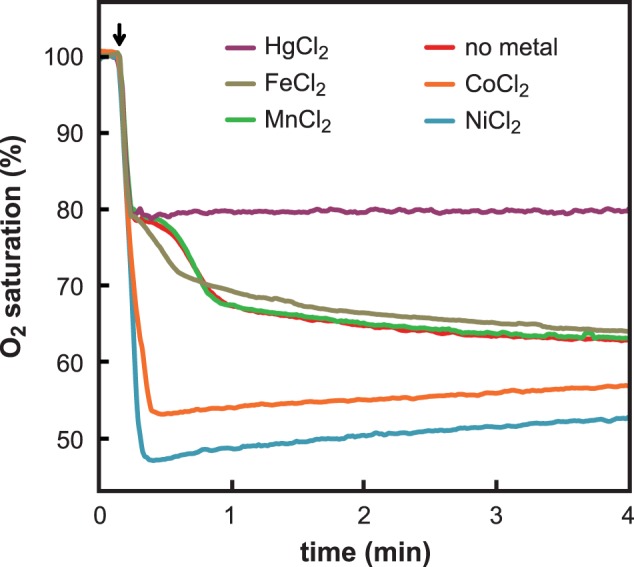
Effect of metal ions on dioxygen consumption during oxidation of sodium selenide.Dissolved dioxygen (O2 saturation percentage) was measured as a function of time in samples initially containing 1.28 ml of the indicated metal (125 µM). At time 10 s (as indicated by the arrow), 320 µl of an anaerobically prepared solution of sodium selenide was added to give final concentrations of 100 µM metal and 100 µM selenide. This mixing caused instantaneous drop in the dioxygen saturation level, from 100% (234 µM) to 80% (187 µM). After this drop, dissolved oxygen concentration varied depending on the assayed metal. At longer times, slight increases in dioxygen concentration were observed in the samples containing mercury, cobalt or nickel ions. These increases originate from slow diffusion of ambient air in the open vials used for the experiments. These slight increases are expected to also occur in the experiments with manganese or iron or without metal.